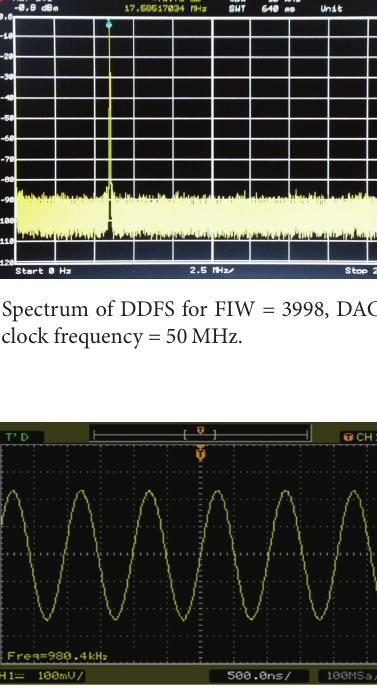
Figure 20: The output sine waveform of the implemented